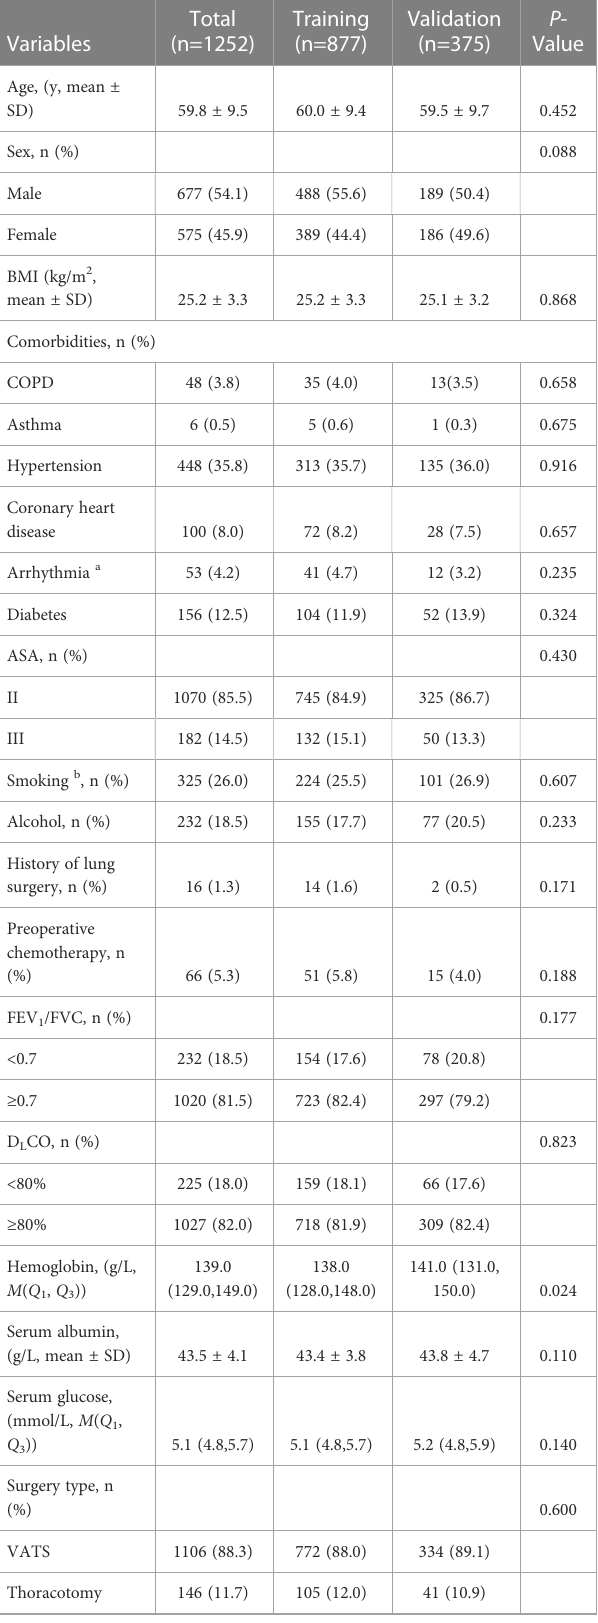
TABLE 1 Patient Basic